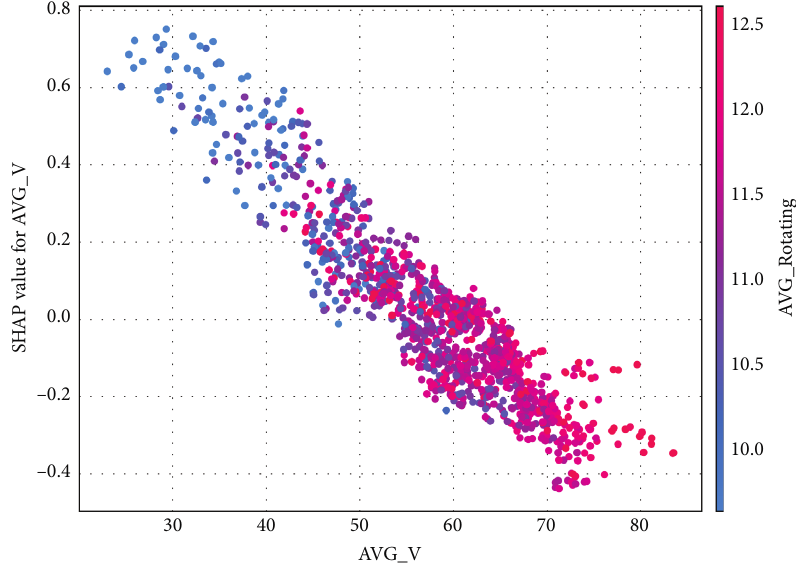
Figure 11: The global impact of average speed on fuel